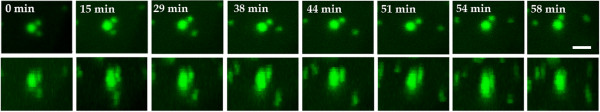
Live imaging of GFP-TRF1 foci in the nucleus of the Syrian hamster fibroblast. In living cells expressing GFP-TRF1, telomeric foci move stochastically. During 1.5h of observation, no fusion of the represented foci was observed. The upper line represents xy-projection of a fragment of the nucleus, and the bottom line – 45o rotation of the same fragment around x-axis. Bar 2μm.